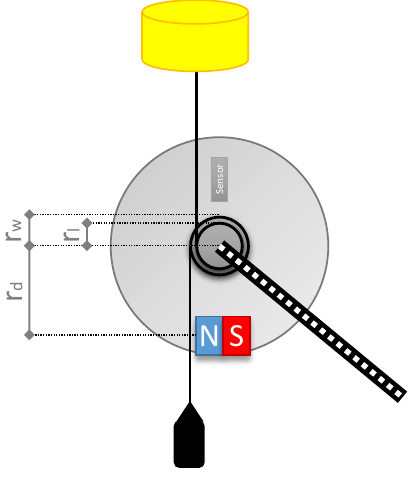
Figure 1. Simplified sketch of the PTO with relevant radii. Here r d is the distance from the disc’s centre to the magnets, r w is the radius of the winch for the line leading to the weight, and r l is the radius of the winch of the line leading to the buoys.